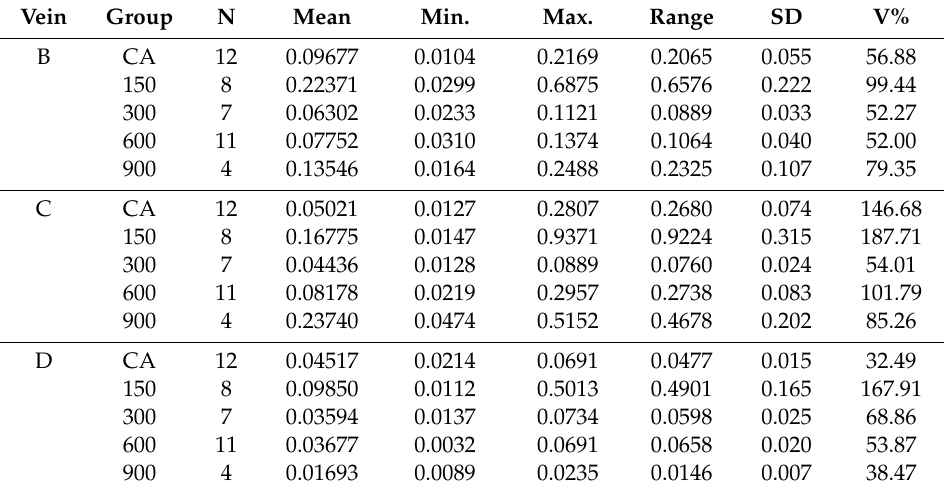
Table 6. Descriptive statistics for the three studied veins of D. melanogaster wings.